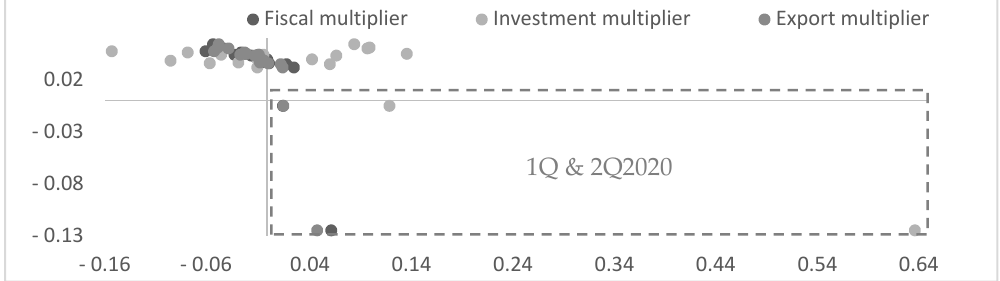
Figure 17. Correlation of changes in autonomous expenditure multipliers to GDP—Portugal, own work, source: Eurostat.